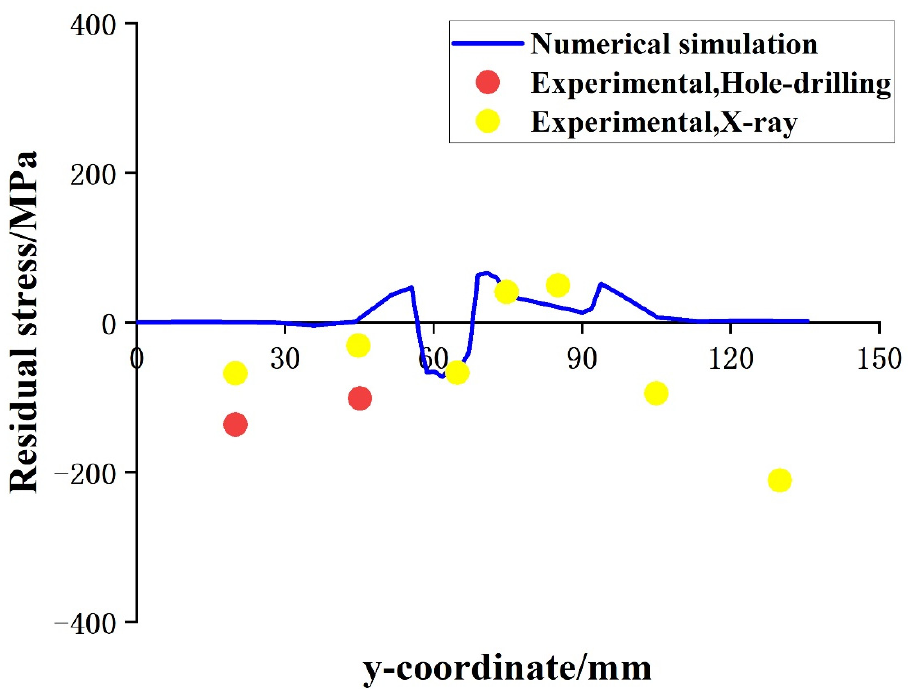
Figure 8. Transversal residual stress (Figure 1, lines A–B) obtained using X-ray diffraction at several electropolishing depths.